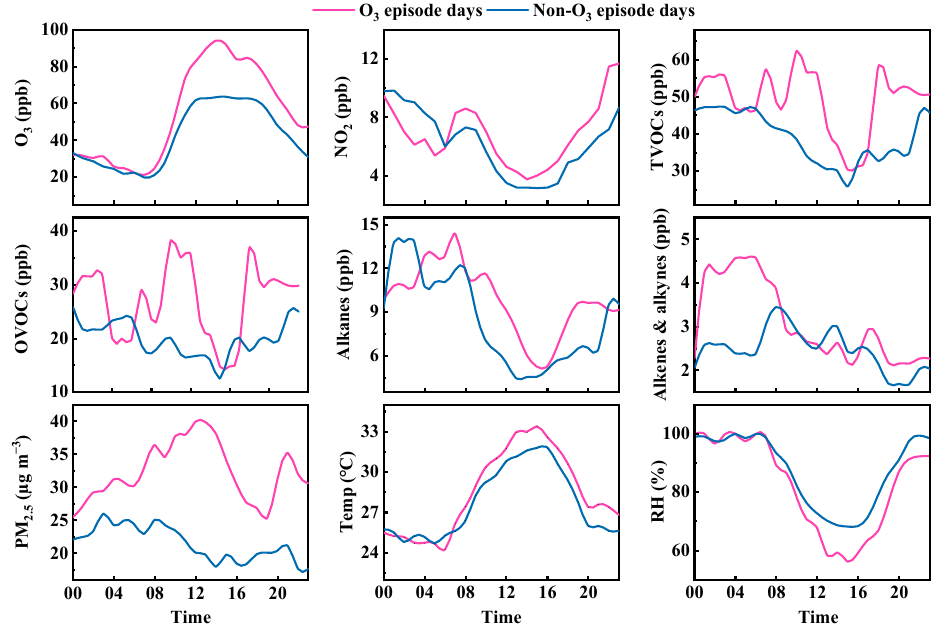
Figure 3. Diurnal variations in major trace gases, VOC groups, and meteorological parameters during the non-O 3 and O 3 episode days. Table 2. Average values of air pollutants and meteorological parameters during the entire observa- tion period, non-O 3 episode days, and O 3 episode days.